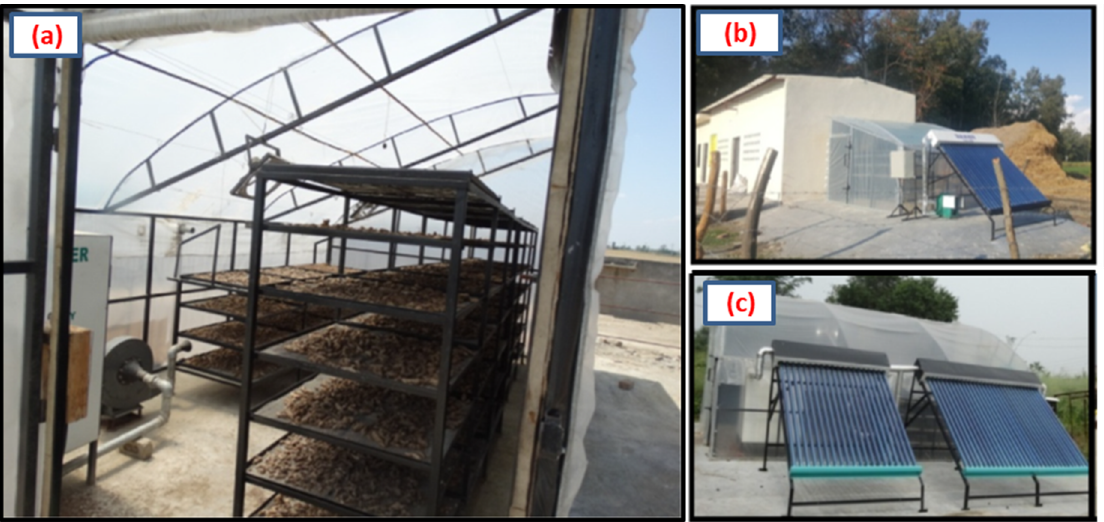
Figure 6. ( a ) Drying arrangement inside a greenhouse and ( b , c ) photos of a few installations [96], with permission No. 5413090348588.